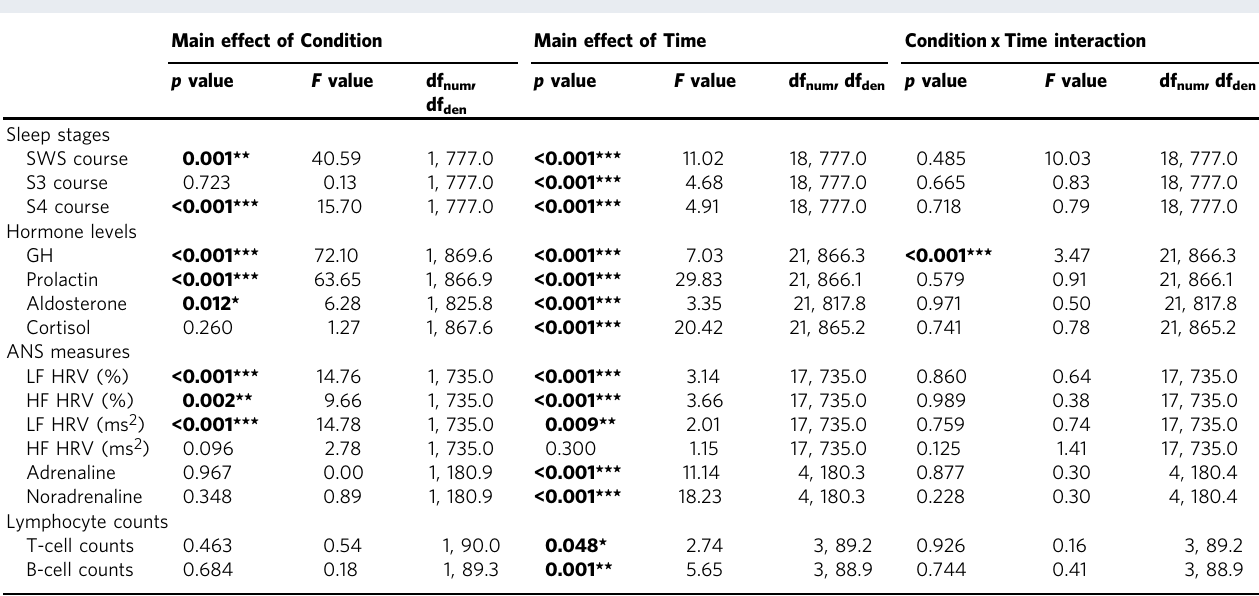
Table 2 Results of linear mixed models